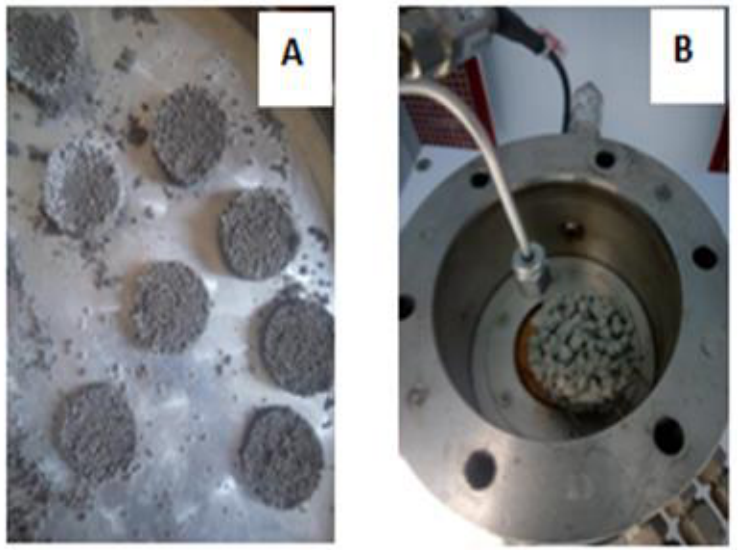
Figure 1. ( A ) Mortar samples of a 5 cm diameter and 1 cm thickness. ( B ) Sample holder with the mortar sample, ready for carbonation experiment